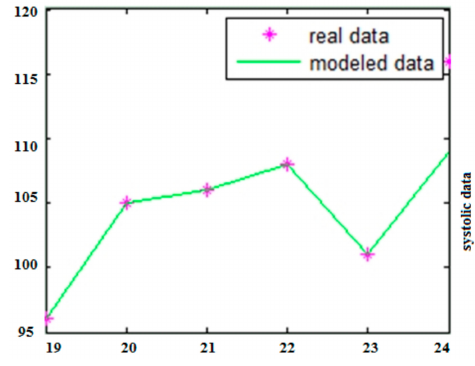
Figure 24. The trend of the systolic